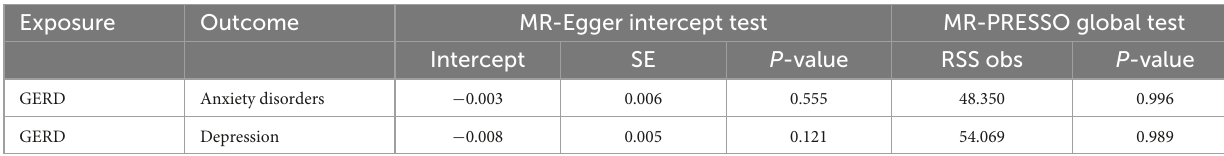
TABLE 8 Results of horizontal pleiotropy by the MR-Egger intercept test and MR-PRESSO global test (based on the IVs screened under the locus-wide significance threshold). Exposure